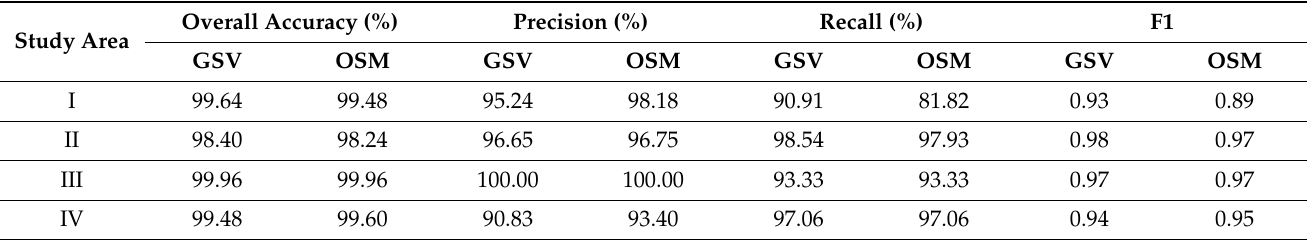
Table A1. The evaluation results of two island datasets (GSV and OSM), in terms of the accuracy